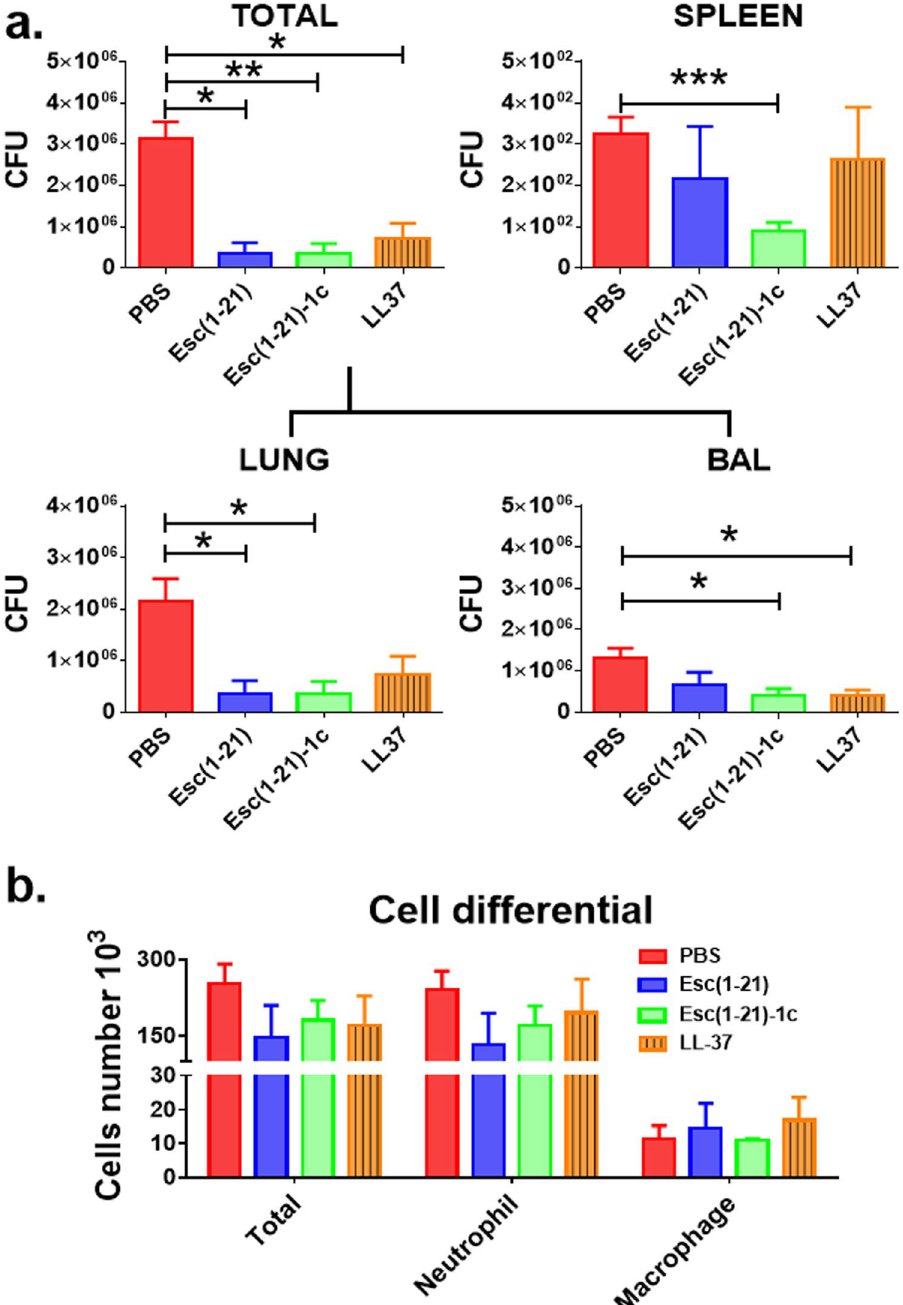
Figure 4. Comparison among Esc(1–21), Esc(1–21)-1c and LL-37 on the number of viable P . aeruginosa cells (CFU). CFU in mouse lungs (Total = lung homogenate + BAL) and spleens (panel a) as well as on the number of inflammatory cells in the BAL (panel b) of pulmonary-infected mice at 4 hours after peptide administration at 0.1 mg/kg were enumerated. Animals were intra-tracheally infected with 3 million PAO1 cells. The peptides were administered intra-tracheally, at 2 μ g (0.1 mg/kg) at 2 hours after bacterial infection. The number of viable Pseudomonas cells in the lung and spleen as well as the number of inflammatory cells in the BAL were evaluated 6 hours after infection, as described in the Experimental section. Results are mean ± SEM from three independent experiments; n = 4–6 mice for each treatment group. Following one-way analysis of variance (ANOVA), posthoc comparisons were made using the Dunnett’s multiple comparison test when the P-value was significant ( p < 0.05). * p < 0.05, ** p < 0.01, *** p < 0.001 for peptide-treated animals versus PBS-treated